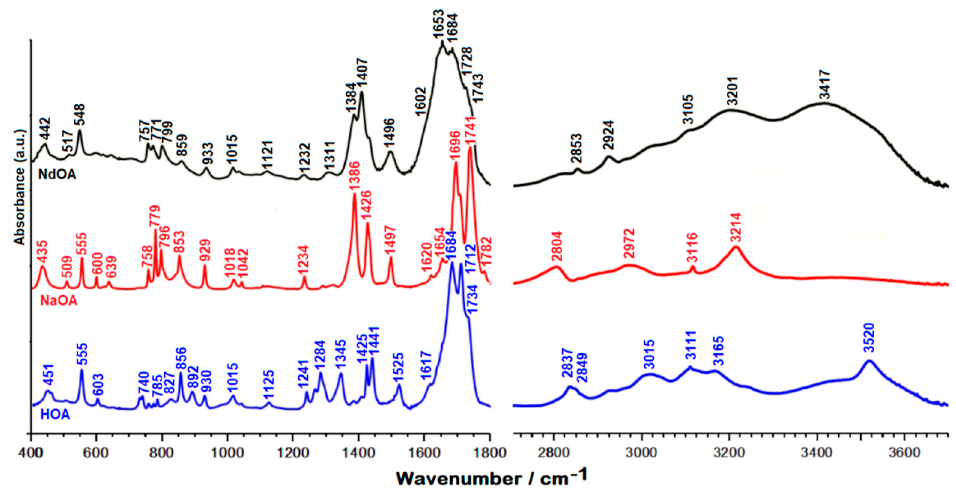
Figure 2. IR spectra of orotic acid (HOA), sodium salt of orotic acid (NaOA), and its Nd(III) complex (NdOA).